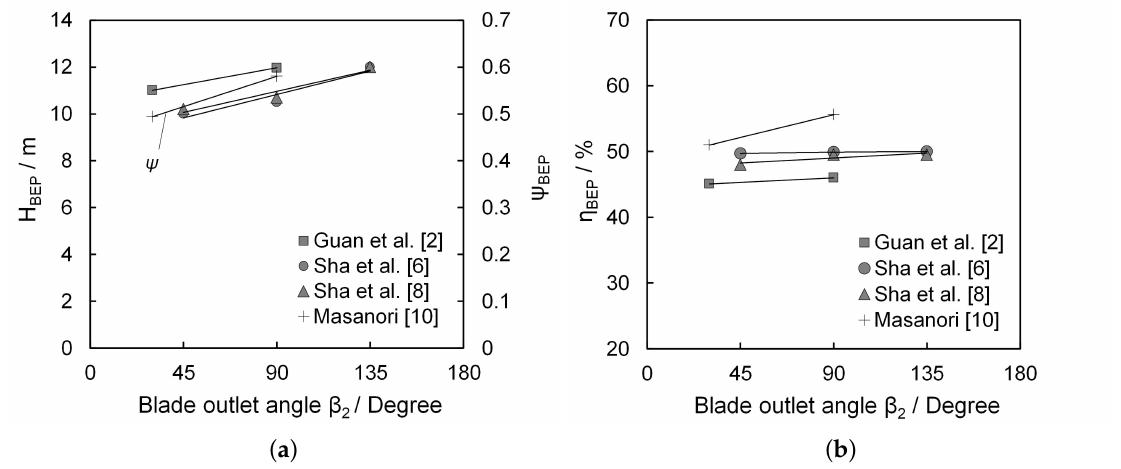
Figure 13. ( a ) Head and pressure coefficient over blade outlet angle; and ( b ) efficiency over blade outlet